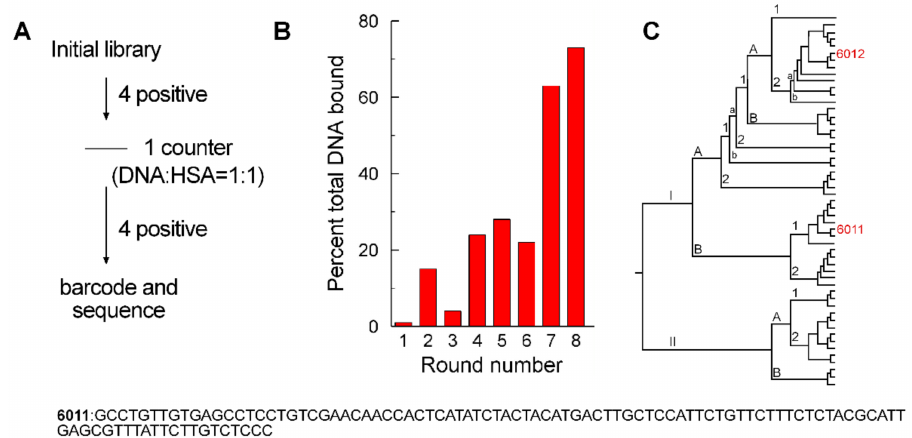
Figure 1. SELEX experiment results: ( A ) Single-stranded DNA aptamers were obtained by multiple rounds of positive selection against sGP and one counter-selection against the filter capture matrix and HSA. ( B ) The percentage of each successive pool that was captured with EBOV sGP in each round increased with subsequent rounds. ( C ) The results of topo-cloning are presented as a cladogram showing the positions of the sequences for 6011 and